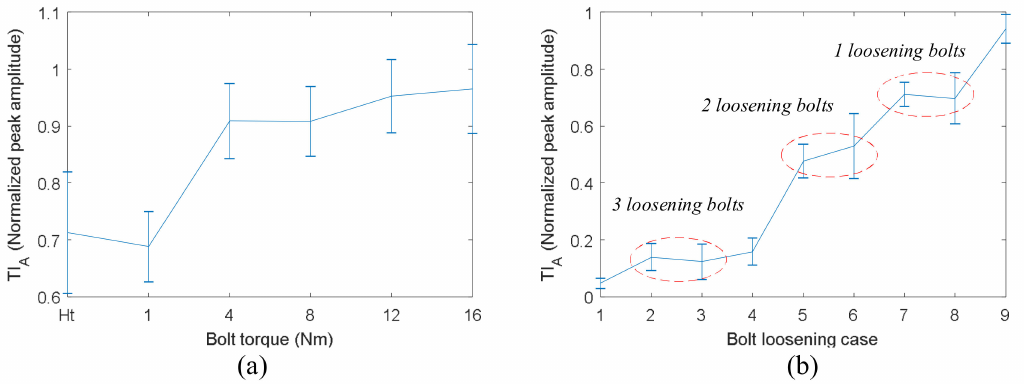
Figure 10. TI A measured by TR method versus bolt tight condition for four-bolt structure: ( a ) different torques of bolt 2; ( b ) different loosening